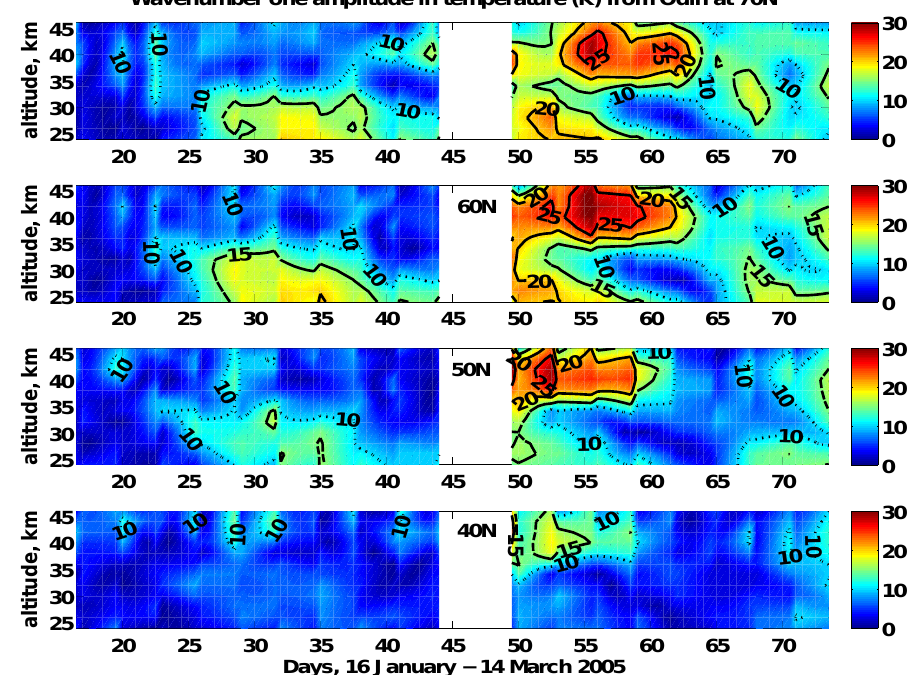
Fig. 11. Wavenumber one amplitude in temperature (K) from Odin SMR data at 70 ◦ N, 60 ◦ N, 50 ◦ N and 40 ◦ N.